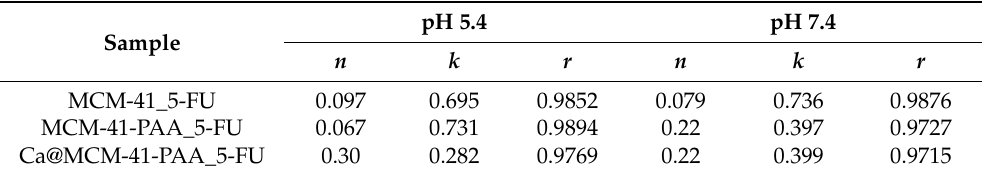
Table 3. In vitro release data of MCM-41, MCM-41-PAA_5-FU, and Ca@MCM-41-PAA_5-FU for various